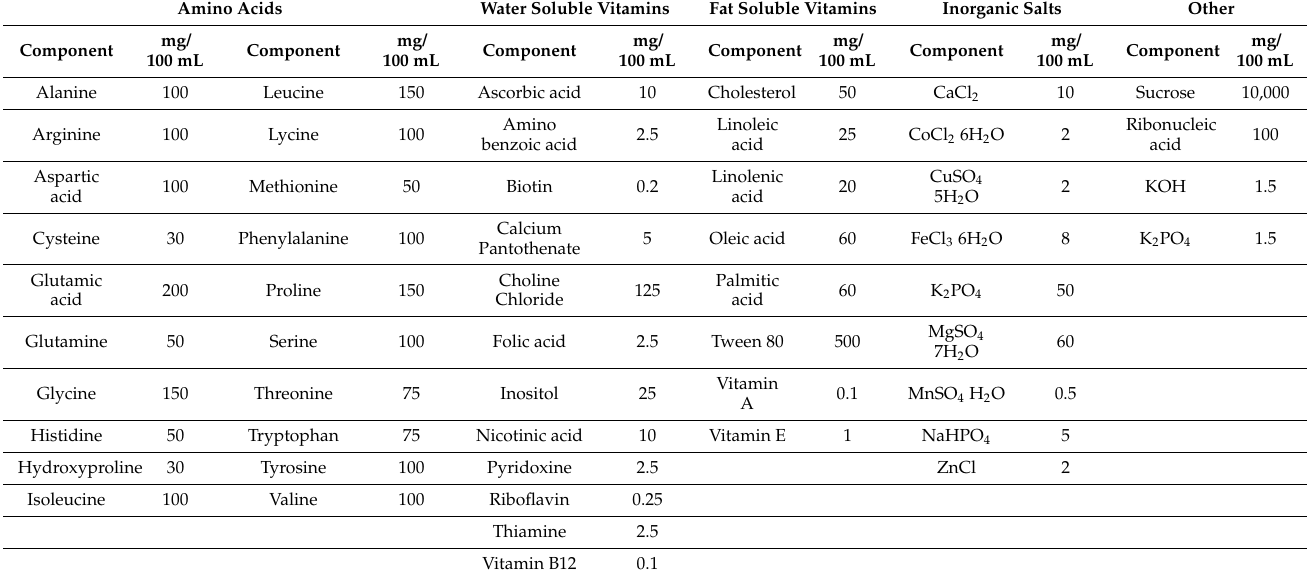
Table 1. Composition of a complete, holidic, (basal) diet used in nutrient deletion and yeast augmentation tests. Amino Acids Water Soluble Vitamins Fat Soluble Vitamins Inorganic Salts Other